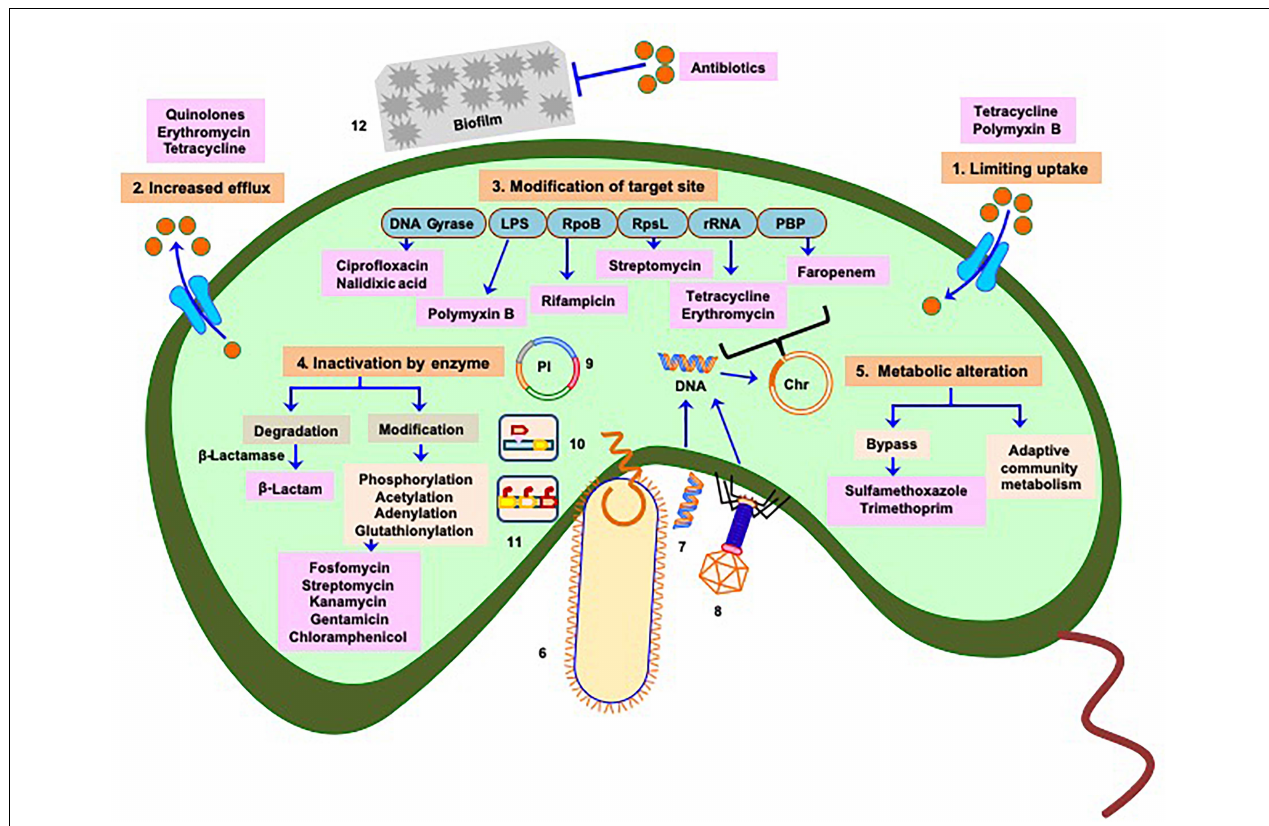
FIGURE 1 | Manifestation of antibiotic resistance mechanisms of Vibrio : multiple mechanisms (intrinsic and acquired) responsible for acquisition of drug resistance or reduced susceptibility include 1. Limiting uptake of drug, 2. Increased drug efflux, 3. Modification of drug target site (chromosome associated phenomenon), 4. Inactivation of drug by enzymatic activity, and 5. Alteration of metabolism as depicted in saffron color boxes. Routes 6, 7, and 8 represent horizontal transfer of antibiotic resistance traits (mobile genetic elements) through conjugation, transformation, and phage transduction, respectively. Plasmids containing antibiotic resistance genes are referred in 9, 10, and 11 represent transfer of mobile genetic elements via transposons and integrons respectively. 12 Physicochemical phenomenon, such as formation of biofilm also play role in acquiring antibiotic resistance. Mechanisms depicted in 6–12 imply greater and faster probability of dissemination of resistance genes to clinical strains. Light blue boxes indicate targets of different antibiotics. Red balls denote concentration of antibiotics responsible for cellular influx or efflux by transporters (cyan) or efflux proteins (cyan), respectively. Antibiotics are represented in pink boxes. Pl represents plasmid, Chr represents chromosome. Based on the origin of antibiotic resistance it appears that most of the resistance mechanisms have been repurposed from intrinsic functions to the incorporation into Mobile Genetic Elements in